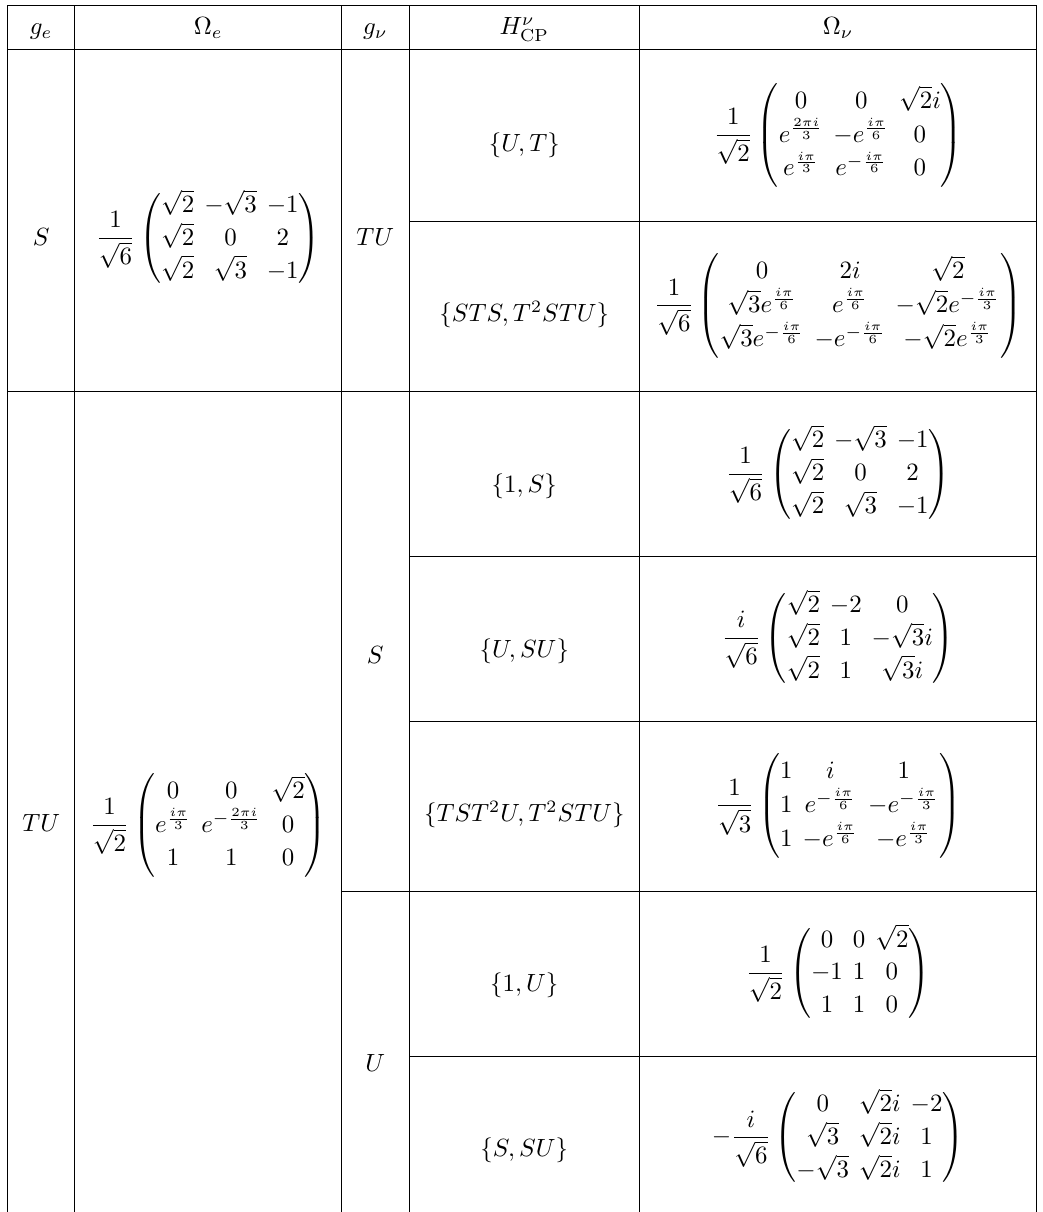
Table 2 . The matrices (cid:10) e and (cid:10) (cid:23) dictated by the residual symmetries G e = Z g e for all seven phenomenologically viable pairs of G e and G (cid:23) . For each pair H (cid:23) remnant GCP transformations, the given matrix (cid:10) (cid:23) provides the Takagi factorisation of the (cid:12)rst element, i.e., X (cid:23) 1 = (cid:10) (cid:23) (cid:10) T